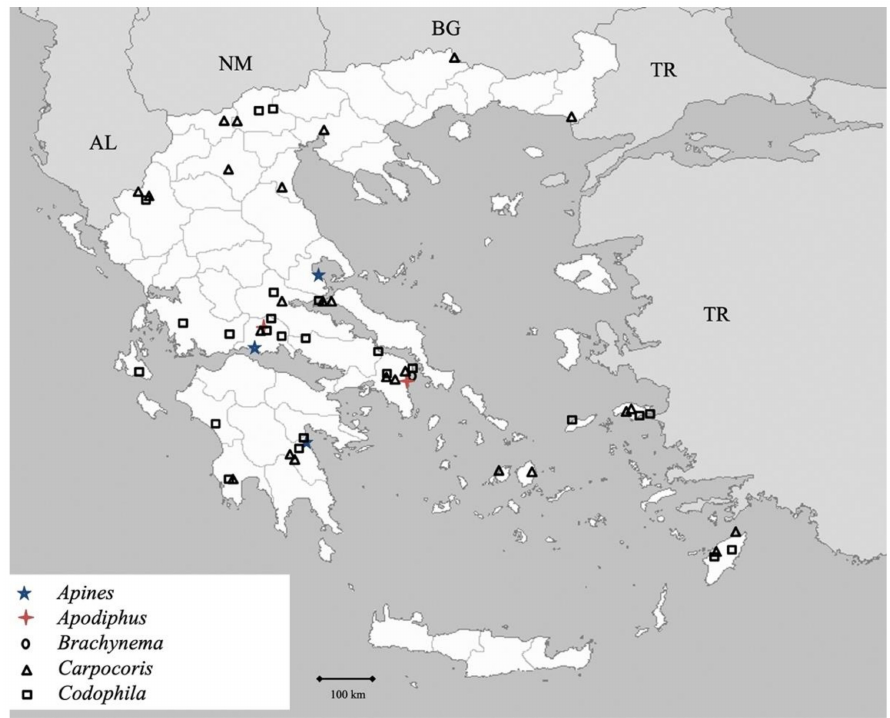
Figure 7. Map showing collecting sites of species of genera Apines, Apodiphus, Brachynema, Carpocoris and Codophila during the present study in